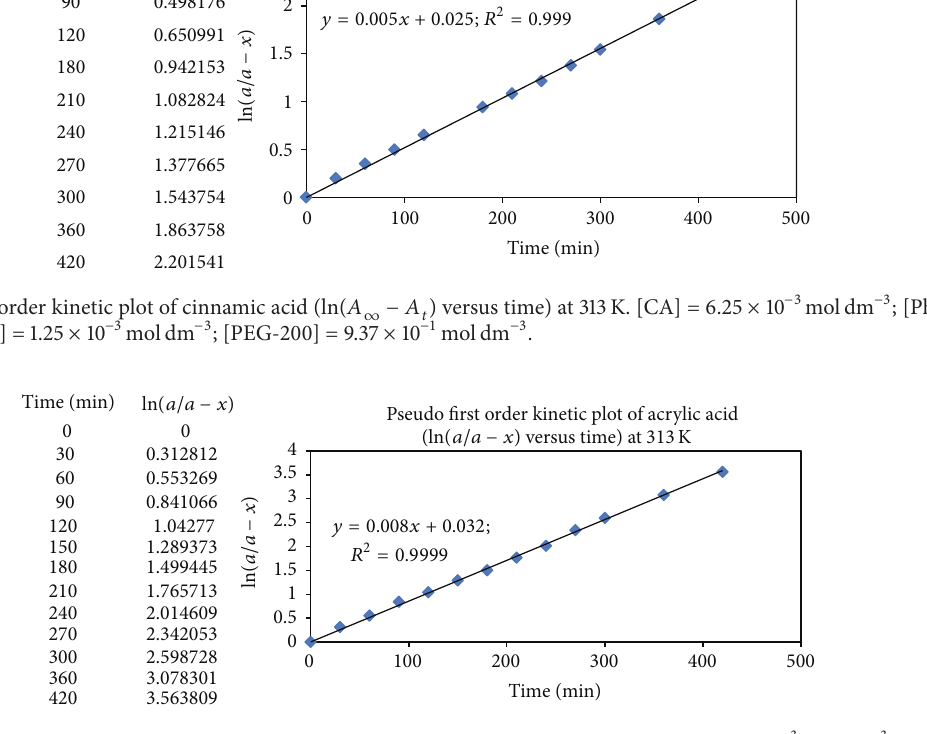
Figure 2: Pseudo first order kinetic plot of acrylic acid (ln (𝐴 ∞ − 𝐴 𝑡 ) versus time) at 313K. [AA] = 6.25 × 10 −3 mol dm −3 ; [Phen] = 3.75 × 10 −3 moldm −3 ; [Fe(III)] = 1.25 × 10 −3 moldm −3 ; [PEG-300] = 6.24 × 10 −1 mol dm −3